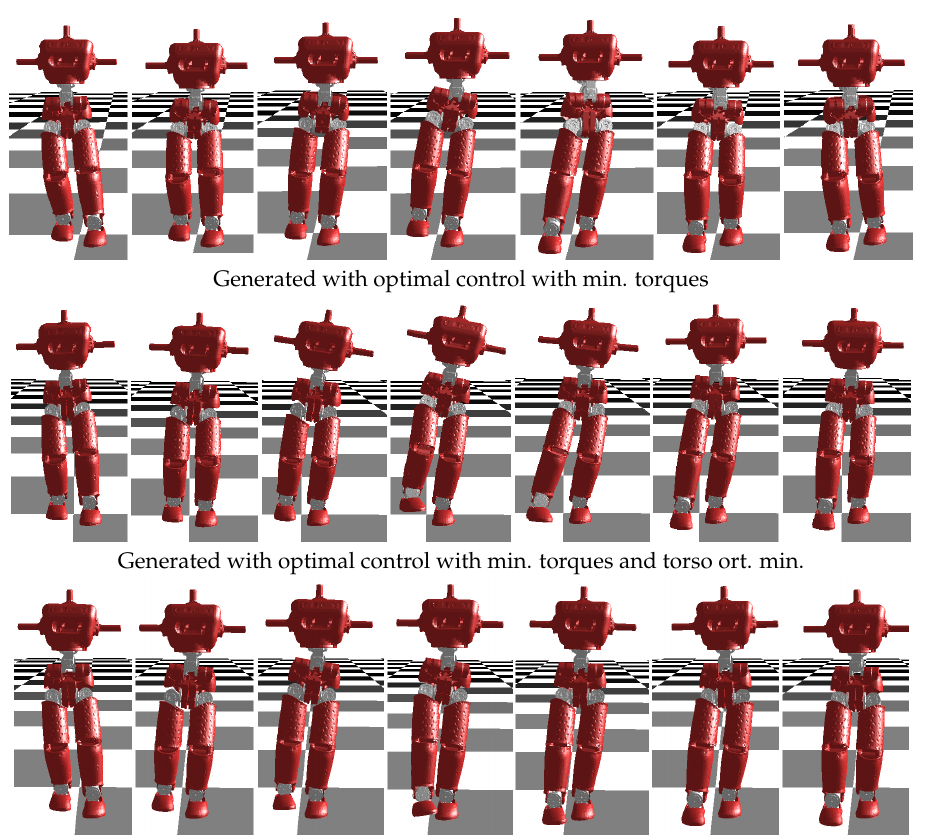
Figure 6. Example sequences of one step motions from using the reduced model, the whole-body model minimizing torques and the whole-body model with torso orientation minimization.